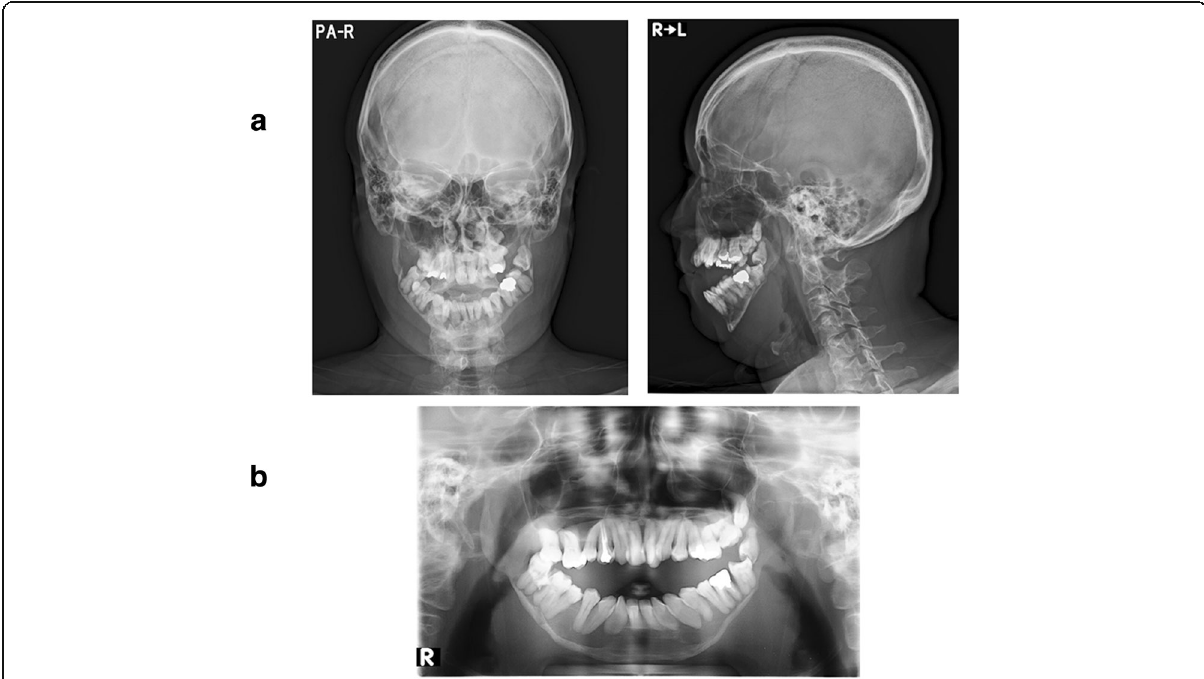
Fig. 2 X-ray images. a Posteroanterior and lateral skull views do not reveal morphological abnormalities of the head or face height and width. b A panoramic radiographic image shows axial and coronal thinning of the alveolar bone in the maxilla and the entire mandibular (condyle, angle, body, and alveolar)